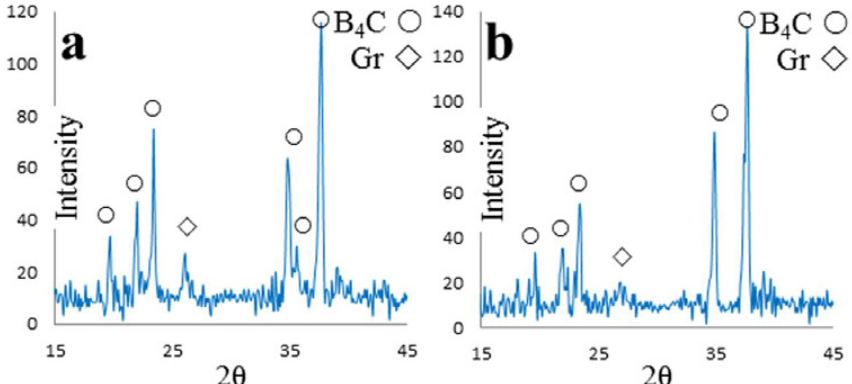
Fig. 5. The XRD patterns of the B C synthesized using activated carbon (a) at 1500 ⁰C and (b) at 1700 4